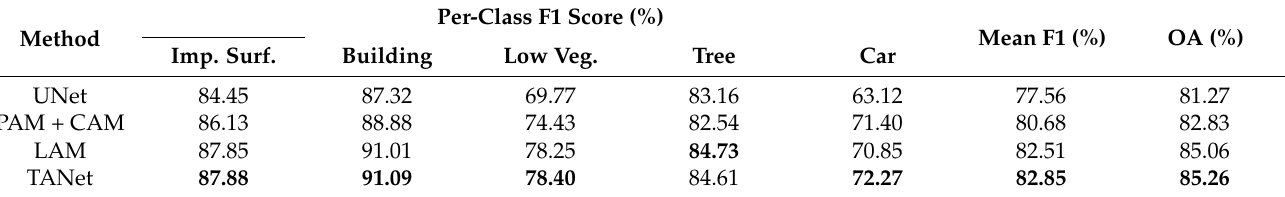
Table 2. F1 score, Mean F1, and OA index results of multi-object on Vaihingen